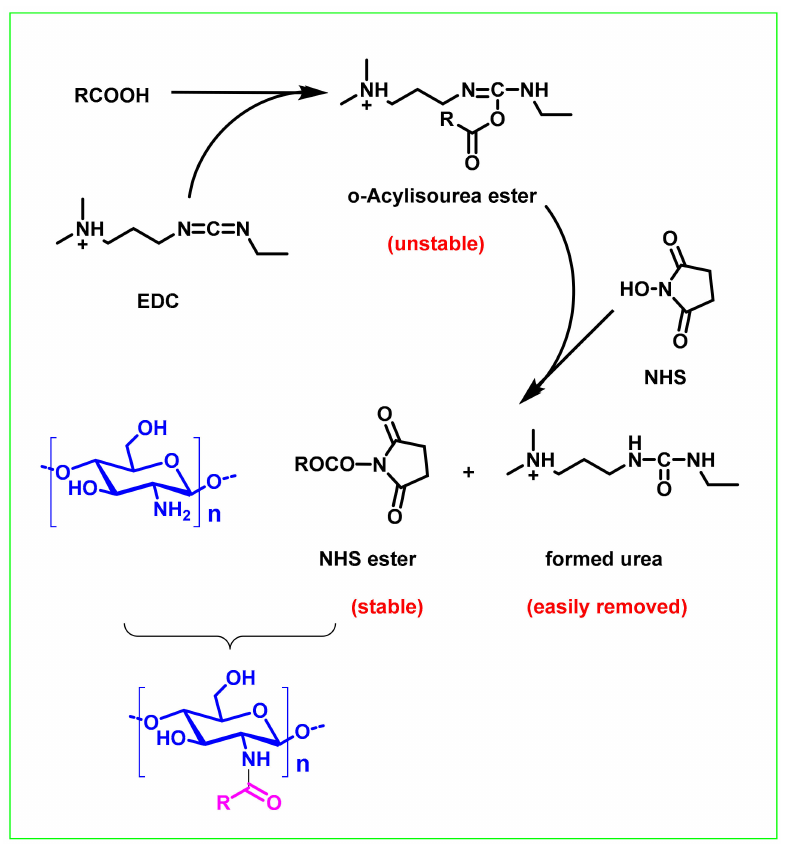
Figure 3. Proposed mechanism of synthesis of a chitosan conjugate by a carbodiimide based chemical coupling